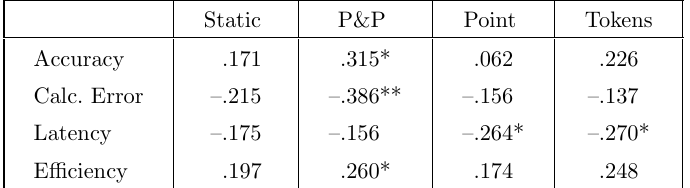
Correlations between task engagement scores and the performance measures in all four experimental conditions